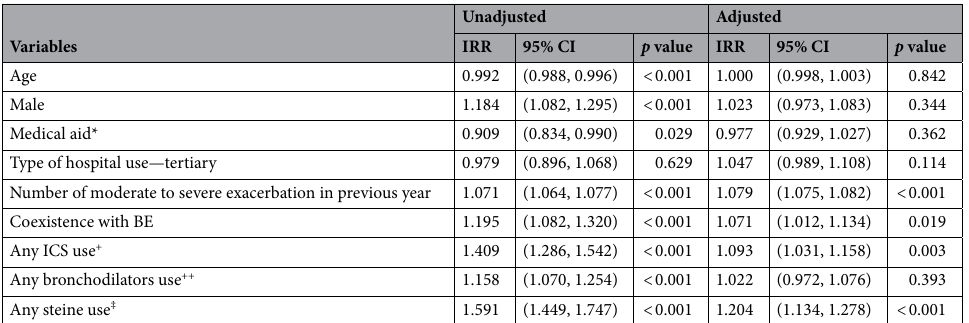
Table 3. Factors affecting moderate to severe exacerbation. IRR incidence rate ratio, CI confidence interval. *Patients with low socioeconomic status were covered by medical aid in Korea. + Any ICS use included ICS only and ICS plus LABA. ++ Bronchodilator included LAMA, LABA. ‡ Any steine included erdosteine, acetylcysteine, and carbocysteine.